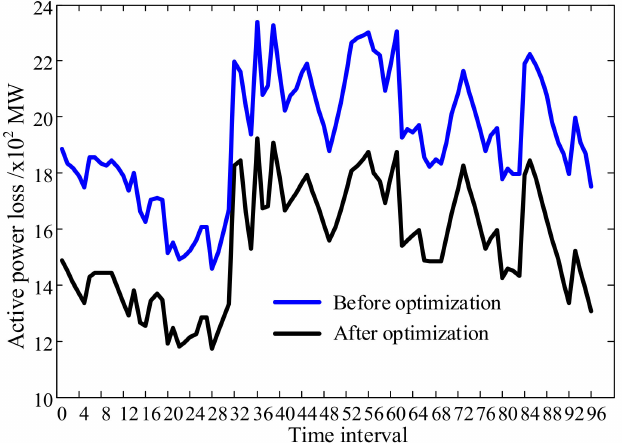
Figure 4. Total active power losses of AC and DC transmission channels before and after